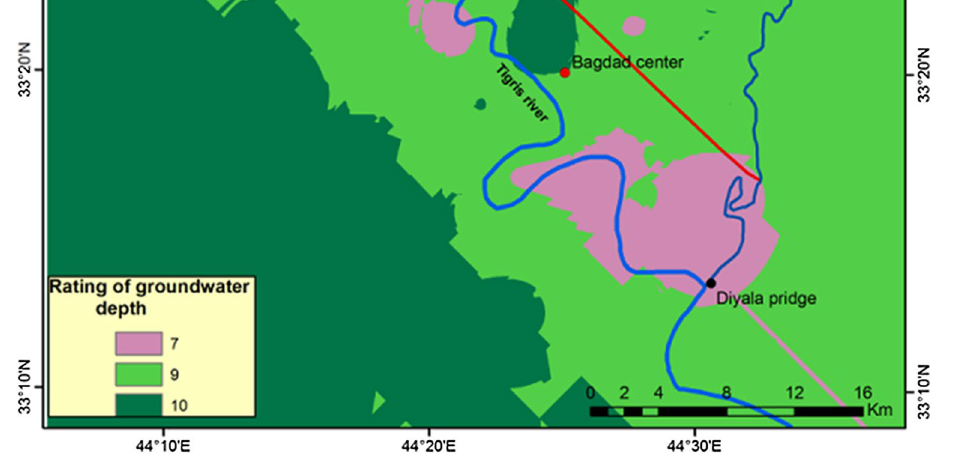
Table 3 DRASTIC rating and weight value for study